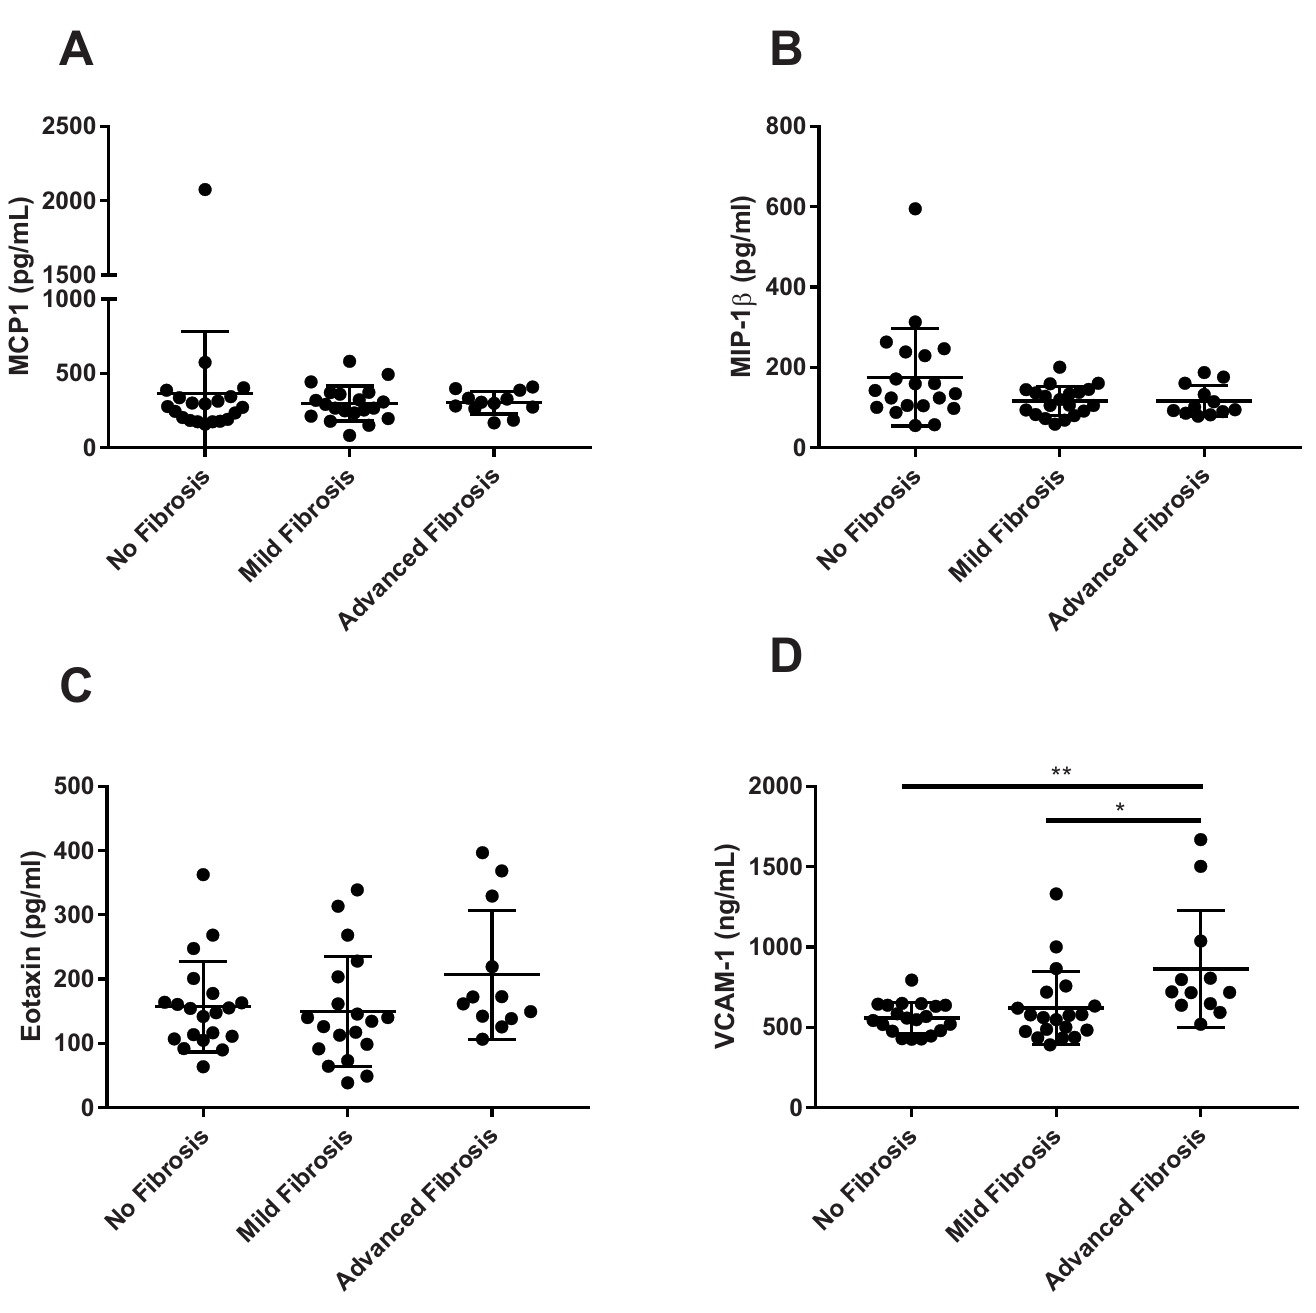
Fig 3. Chemokines and VCAM-1 analyzed by NASH fibrosis severity. (A) MCP-1, (B) MIP-1b, (C) Eotaxin and (D) VCAM-1. � p < 0.05, �� p < 0.01 vs Advanced Fibrosis group.